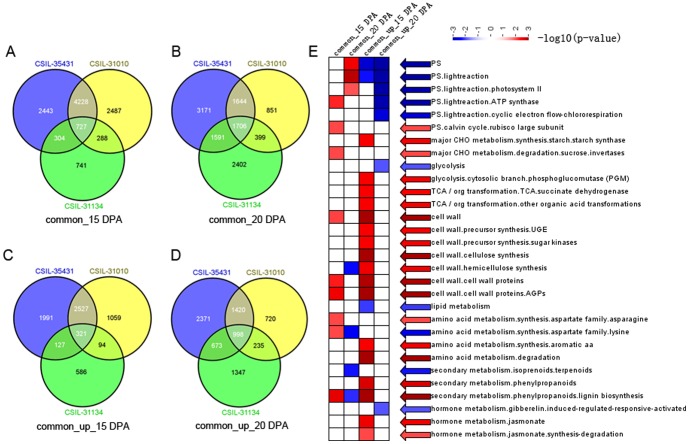
Analysis of common and common upregulated DEGs among three stronger fiber CSILs.(A, B, C, D) Common and common upregulated DEGs among three stronger fiber CSILs at 15 and 20 DPA. Common_up, common regulated DEGs. (B) Functional enrichment analysis of these DEGs using mapman software (Summary statistic type, wlcoxon). Colors from blue to red indicated that functions were enriched more significantly with smaller p-values.